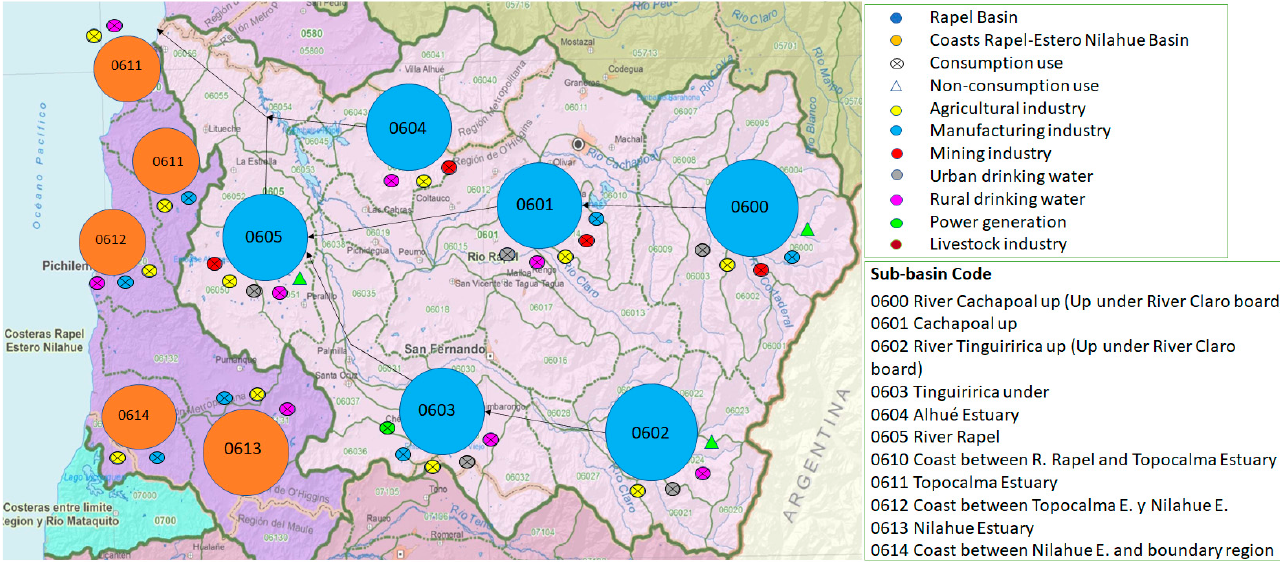
Figure 4. Conceptual model per sub-basin in the region (based on data from [8,9]).